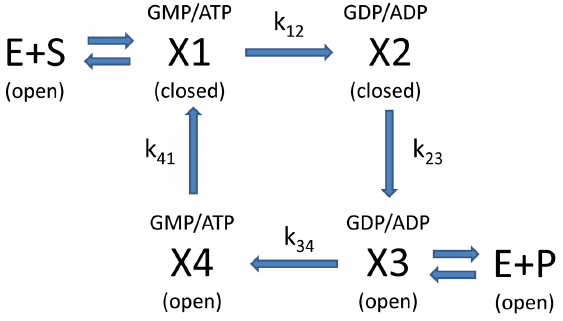
Figure 6. An alternative two-dimensional reaction scheme which is also consistent with the observations. Here two forms of the enzyme, open and closed, are stabilized by the presence of GDP/ ADP and GMP/ATP, respectively. The essentially uni-directional arrows k 12 and k 34 can be accomodated within standard transition state theory if one assumes, in both cases, a high barrier for the reverse process. As with the scheme of Fig. 5, we have to assume that under high Mg conditions the arrows in the loop are reversed.